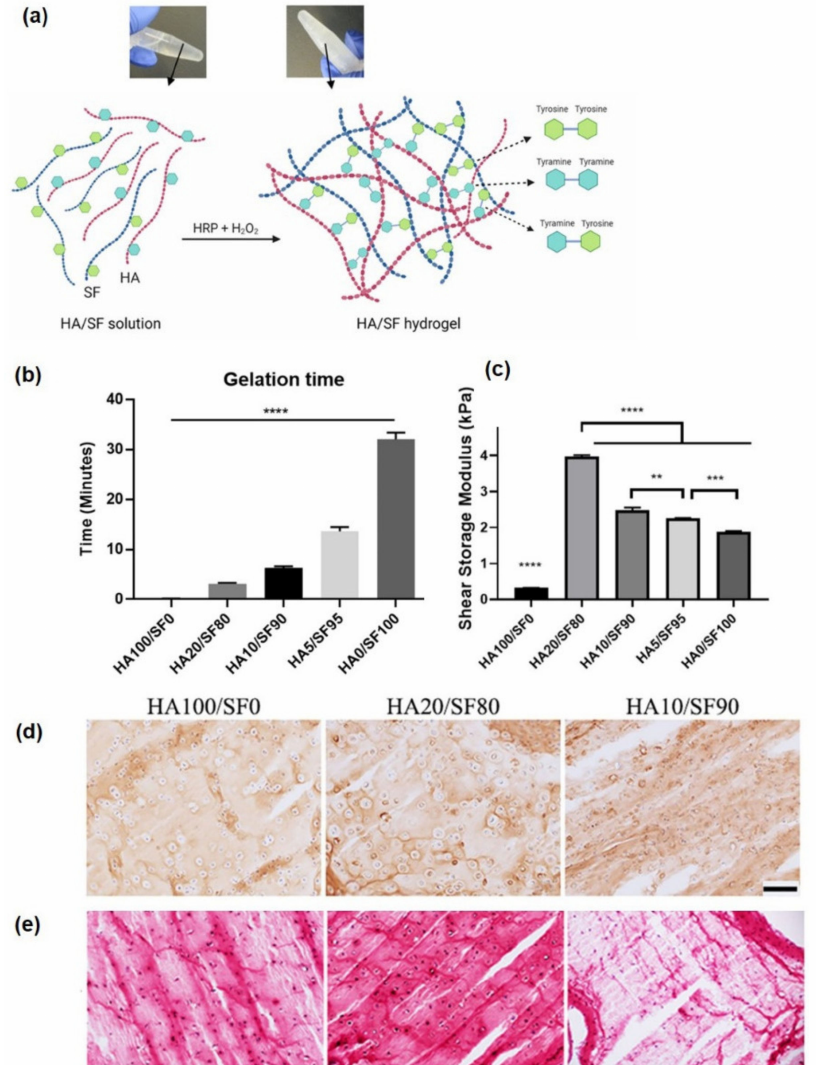
Figure 4. Schematic illustration of ( a ) the enzymatic cross-linked SF/HA-Tyr composite hydrogel, ( b ) the gelation time of the hydrogel was decreased with an increase in HA concentration, and ( c ) HA20/SF80 showed the maximum G (cid:48) values of 3.94 kPa among all the groups ** p <0.001 *** p < 0.0005 **** p < 0.0001. Immunohistochemical characterization revealed ( d ) maintenance of chondrocyte cell morphology on day 21 (Safranin-O staining) and ( e ) increased the accumulation of type II collagen (immunostaining). Adapted with permission from ref. [85], Copyright 2021